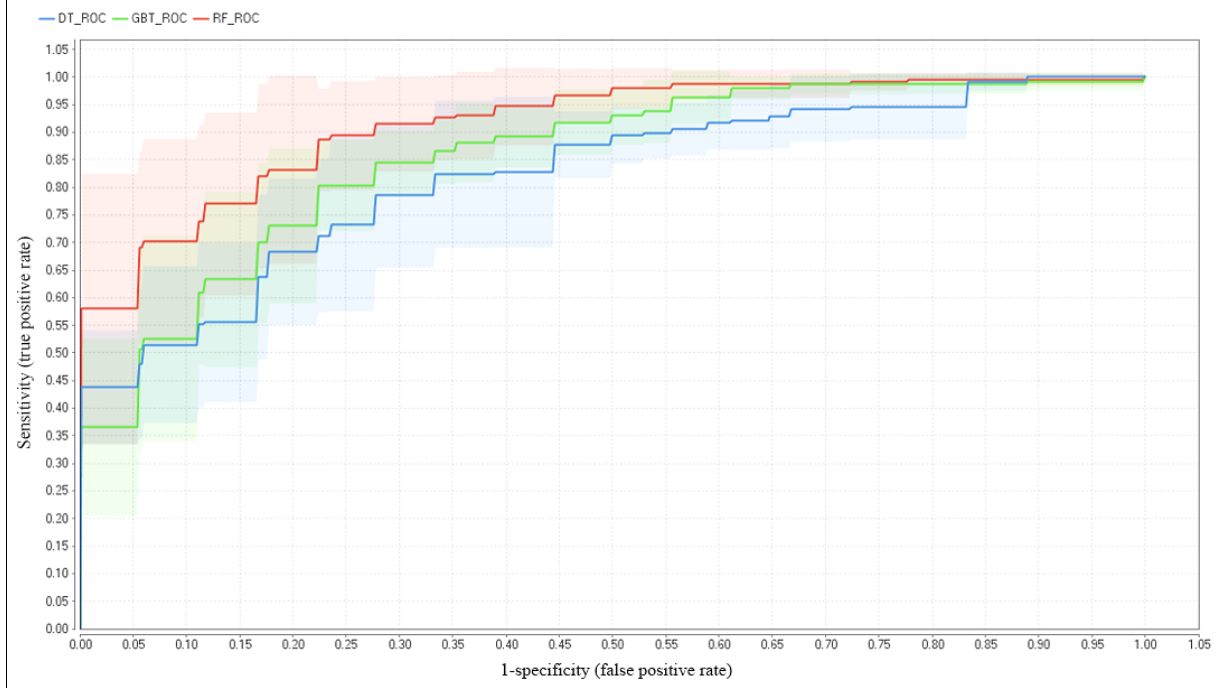
Figure 3. Depression ROCs curves of decision tree (blue line), gradient boosting trees (green line), and random forest (red line) using only three trauma items Table 6. The accuracy, precision, and recall of depression prediction model using only three trauma items with